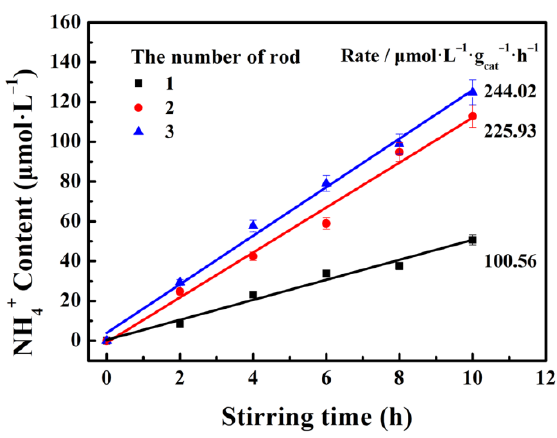
Figure 8. Tribocatalytic N 2 fixation performance of g-C 3 N 4 with the different number of stirring rods.